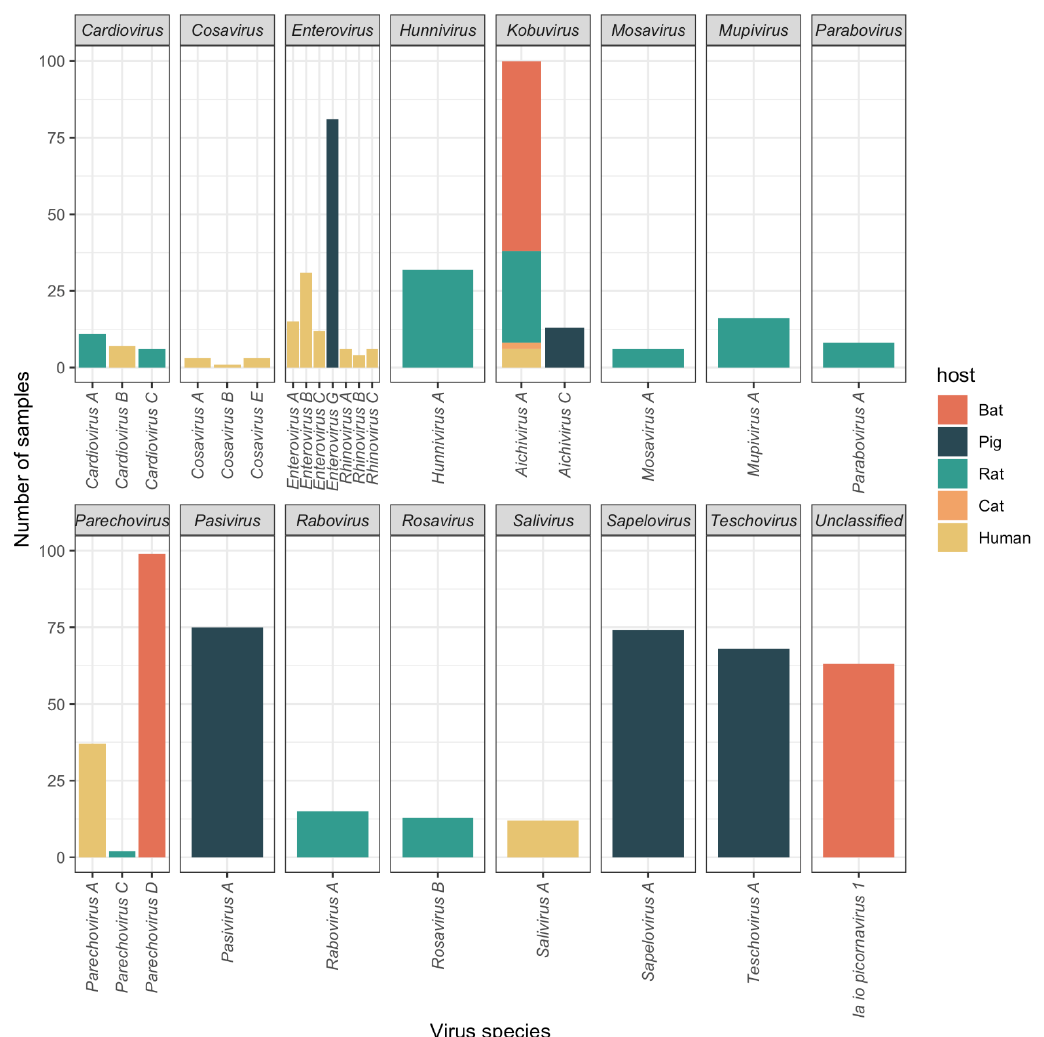
Figure 2. Prevalence of picornavirus species in different hosts by DIAMOND BLASTX top hit.